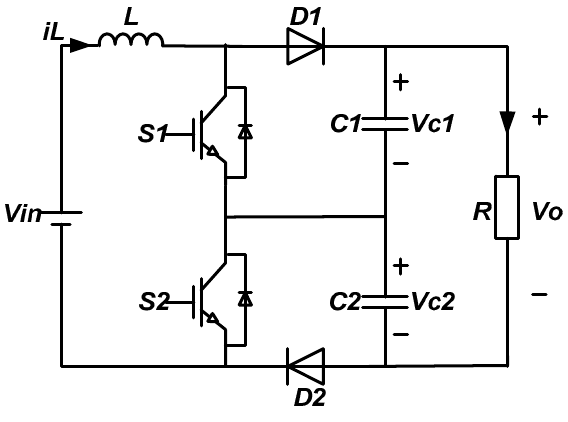
Figure 2. Main circuit of the boost-TL converter.